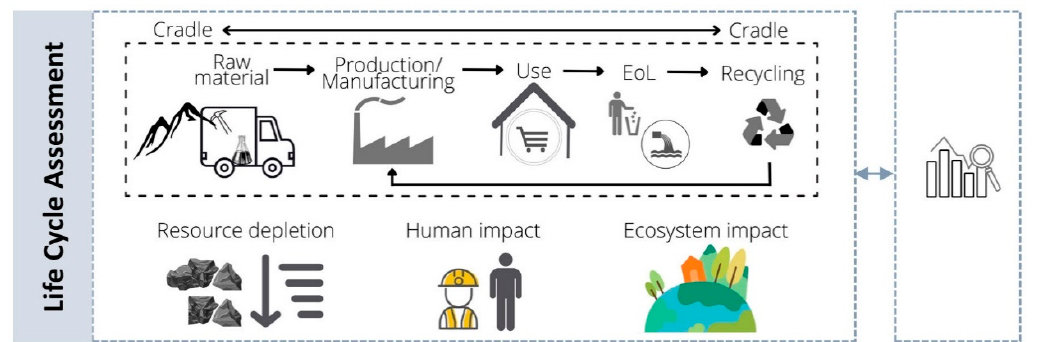
Figure 8. General conceptual framework of LCA representing the four main phases. Phase I: Cradle ‐ to ‐ cradle is one of the system boundaries that could be established in this stage; phase II: during the LCI, for each of the stages of the life cycle, all the inputs (e.g., natural resources) and outputs (e.g., emissions) within the system boundaries are accounted for; phase III in the LCIA, different models are used to translate the quantity of each emission in order to evaluate the potential impacts; phase IV: interpretation of the LCA results. EoL: end ‐ of ‐ life.